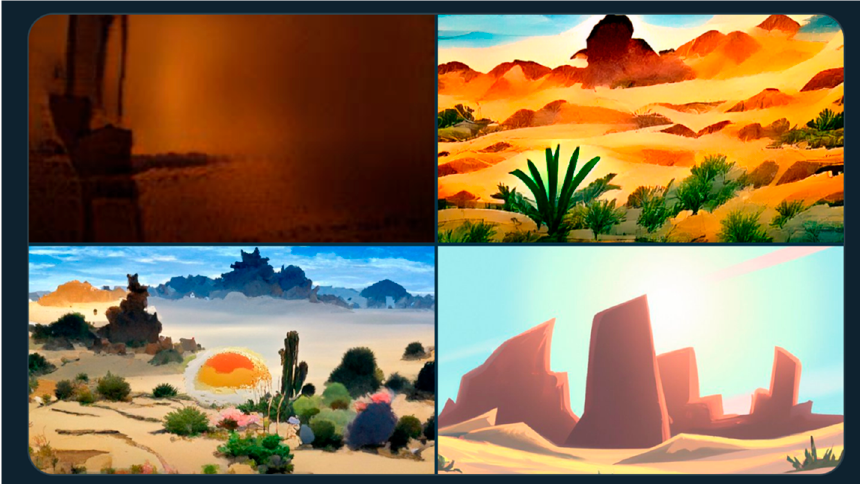
Figure 3. The input “Desert landscape at sunrise in Studio Ghibli style”, applied to AttnGAN (2018), CLIP + VQGAN (2020), CLIP + Diffusion (2021), and DALL ∙ E 2 (2022), highlighting rapid progress. CLIP + VQGAN (2020), CLIP + Diffusion (2021), and DALL · E 2 (2022), highlighting rapid